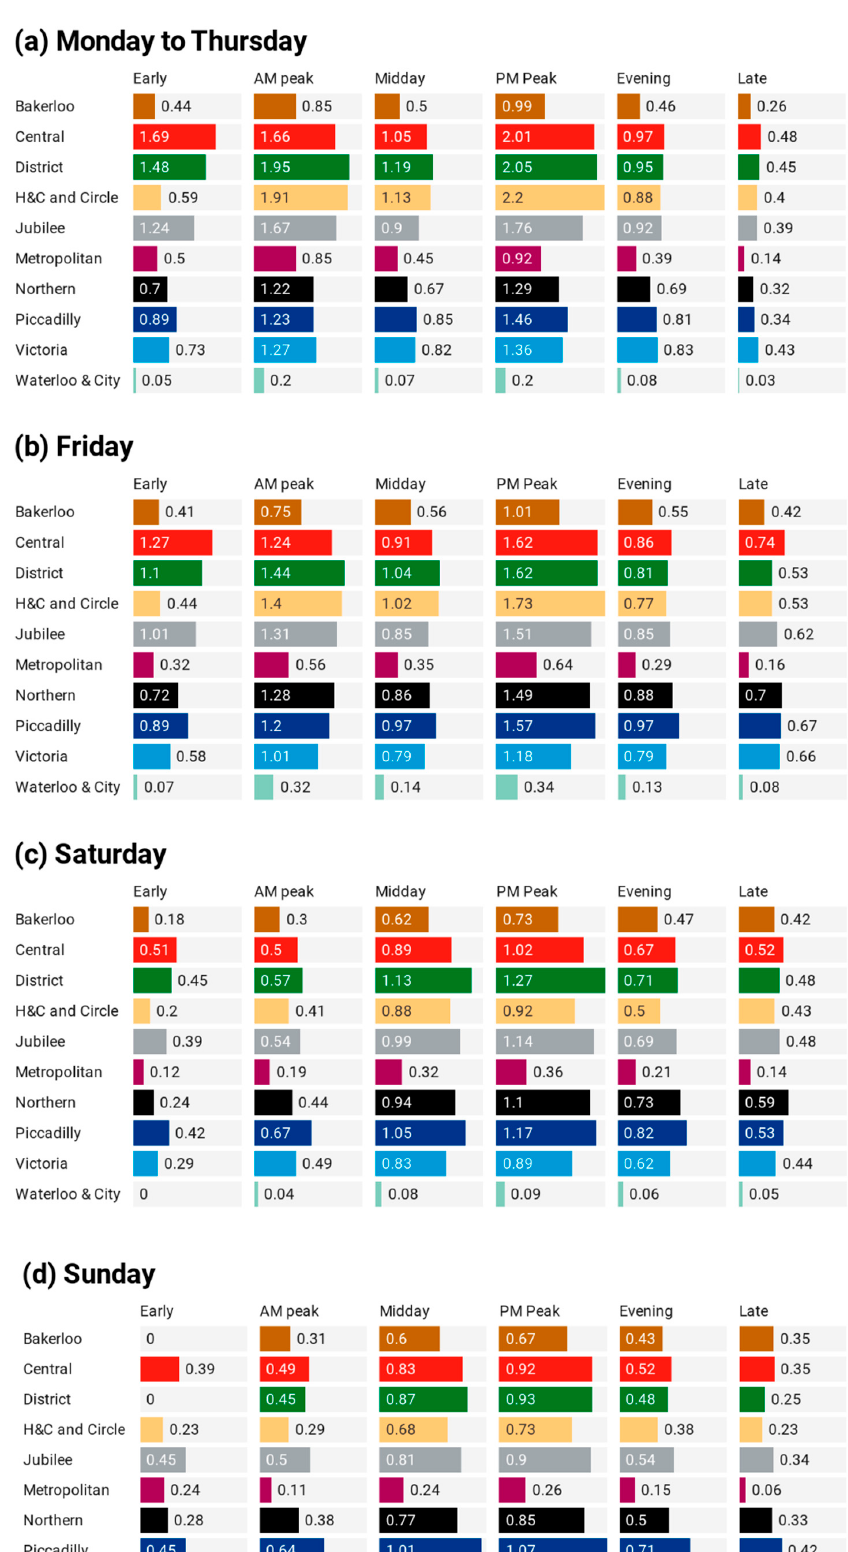
Figure 13. LU occupancy rate by line and time band.